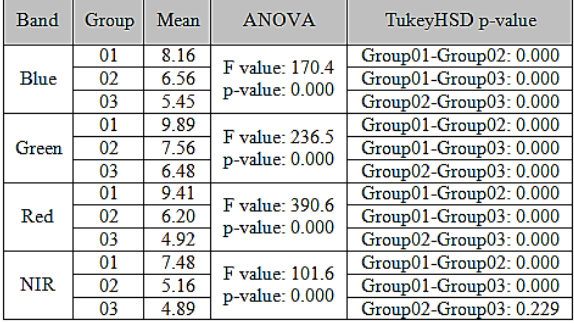
Table 2. ANOVA analyses of reflectance values among different sample locations